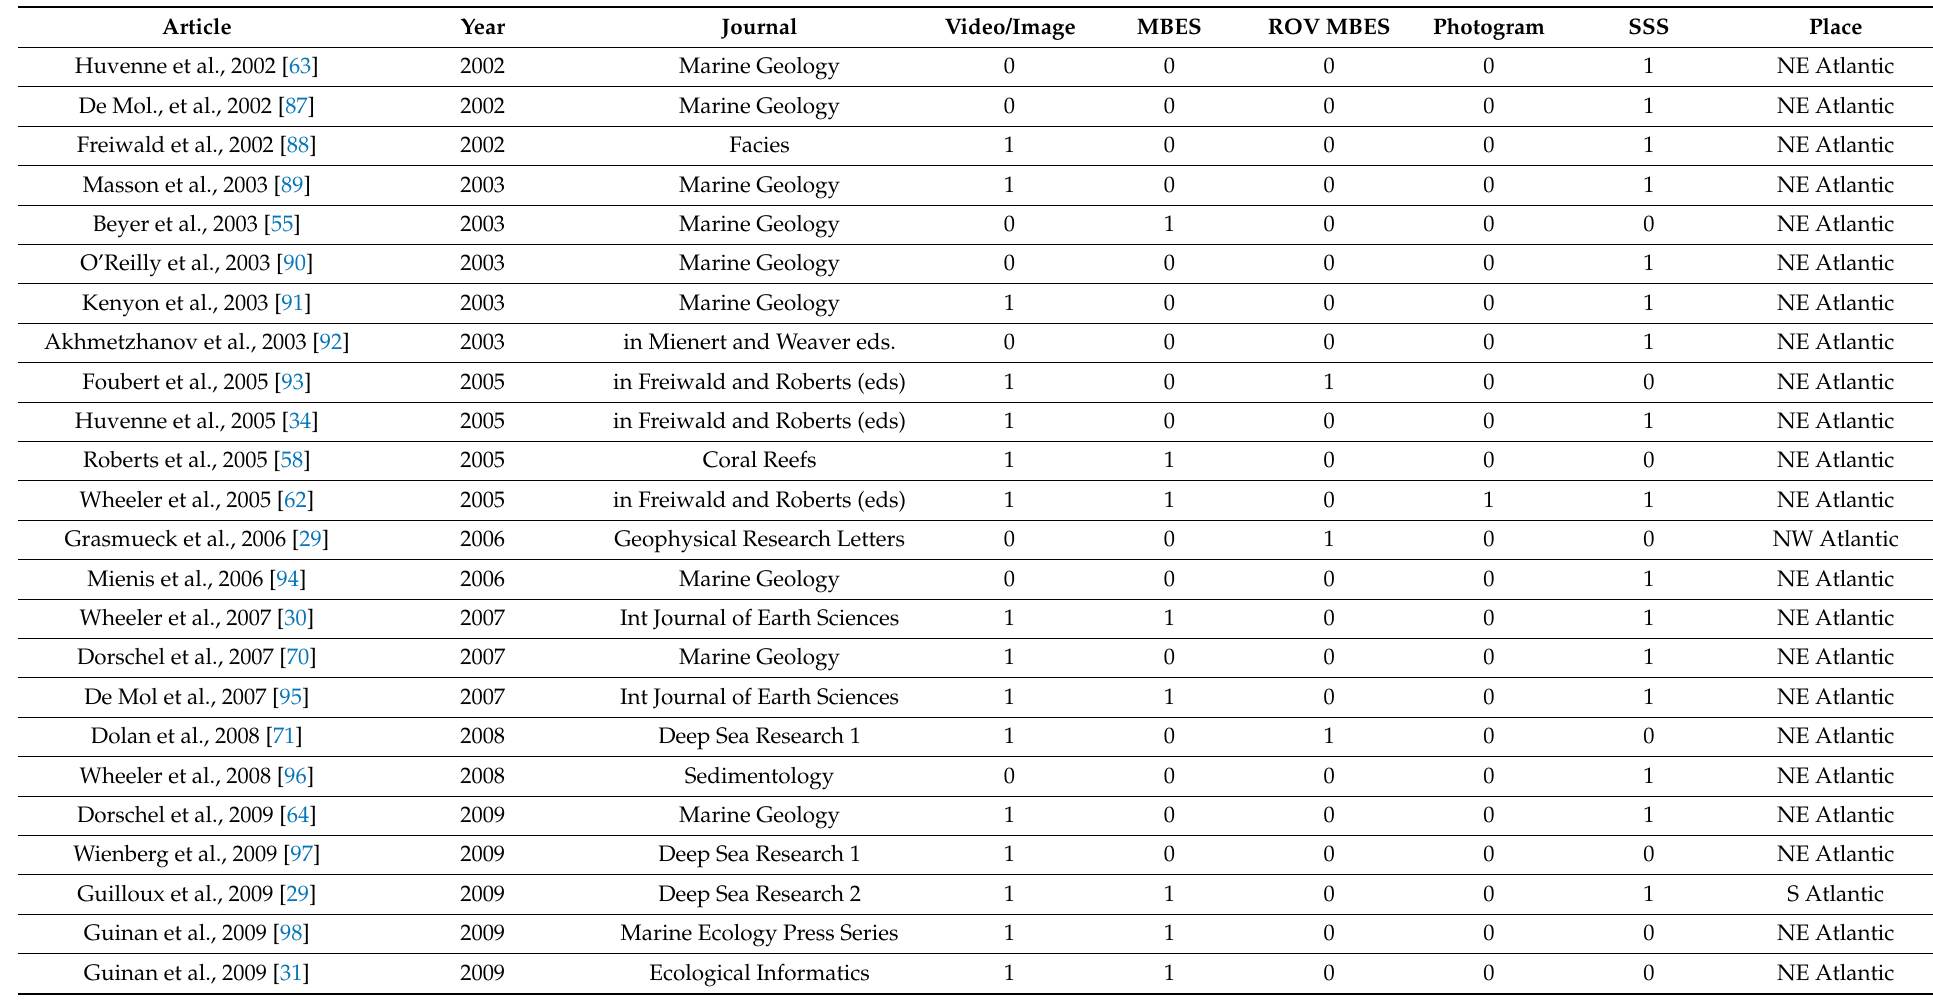
Table 1. List of studies whose primary methods utilize spatial mapping and processing of cold-water coral habitats. Mapping acquisition methods include multibeam echosounder (remotely operated vehicle- and vessel-mounted), side scan sonar, photogrammetry, or repeat mapping. Spatial data processing methods include descriptive, manual, automated (and semi-automated), and machine